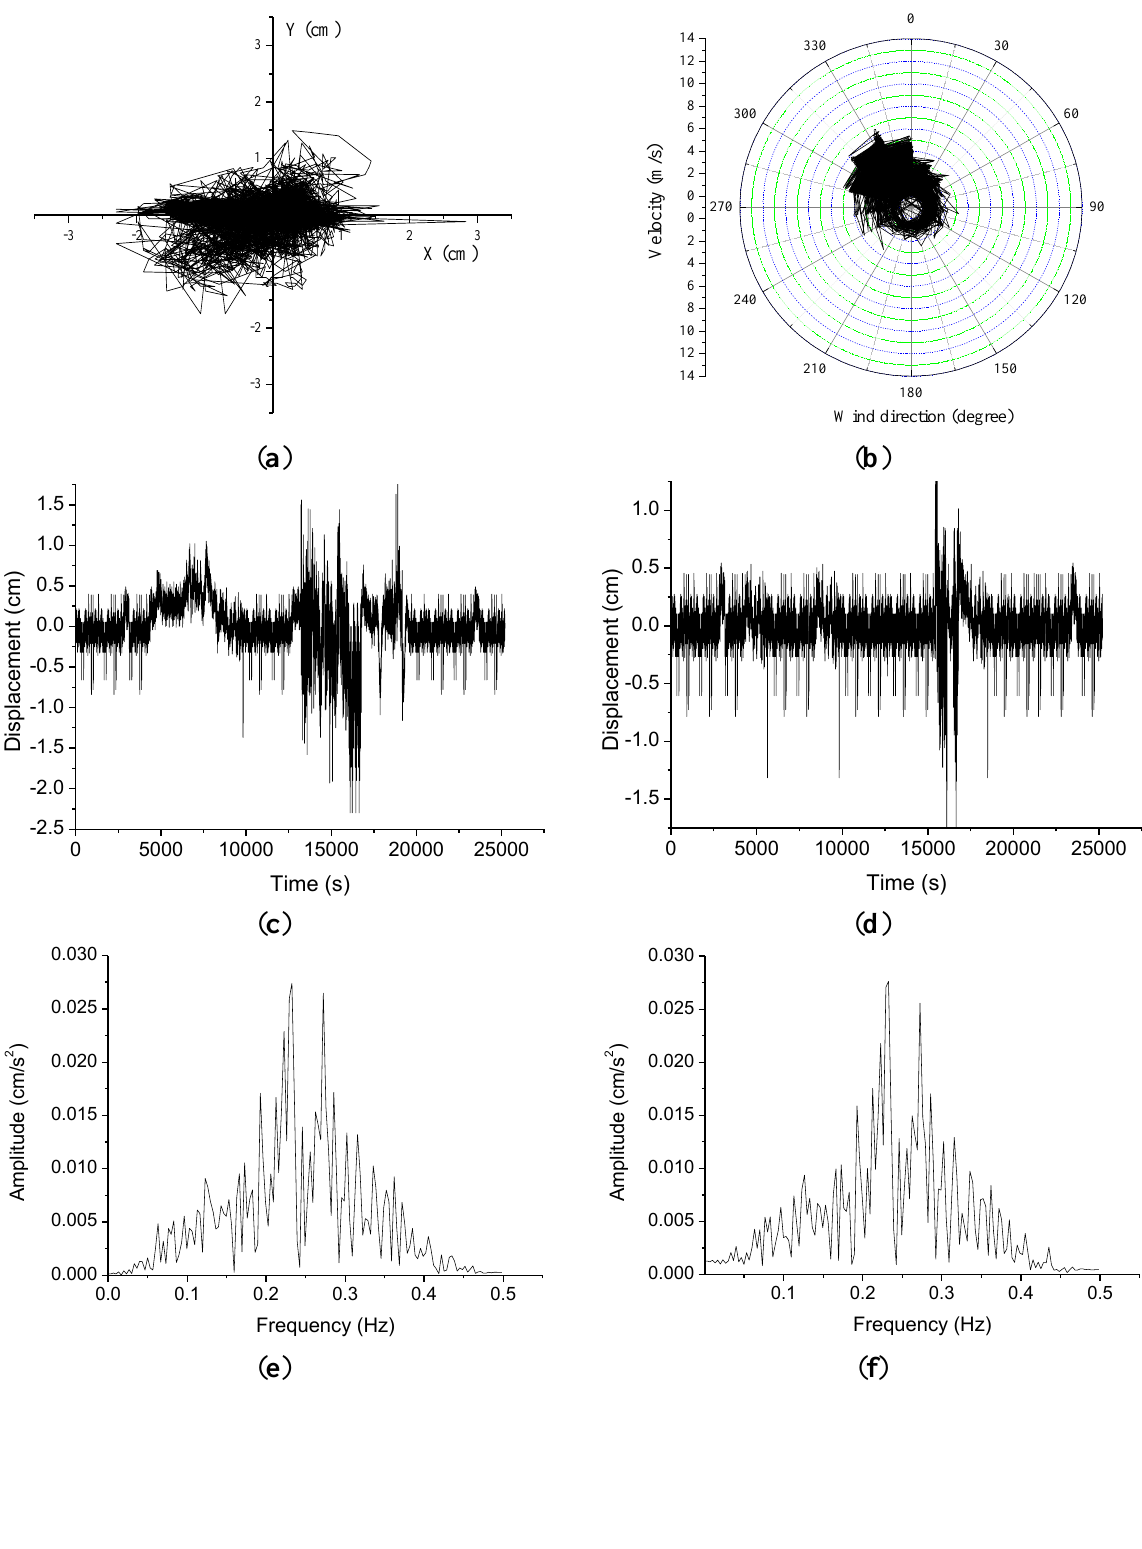
Figure 5. Displacement and wind speed before outrigger truss installation: ( a ) GPS displacement; ( b ) Wind speed and direction; ( c ) Time series in X-direction; ( d ) Time series in Y-direction; ( e ) Fourier spectrum in X-direction; ( f ) Fourier spectrum in